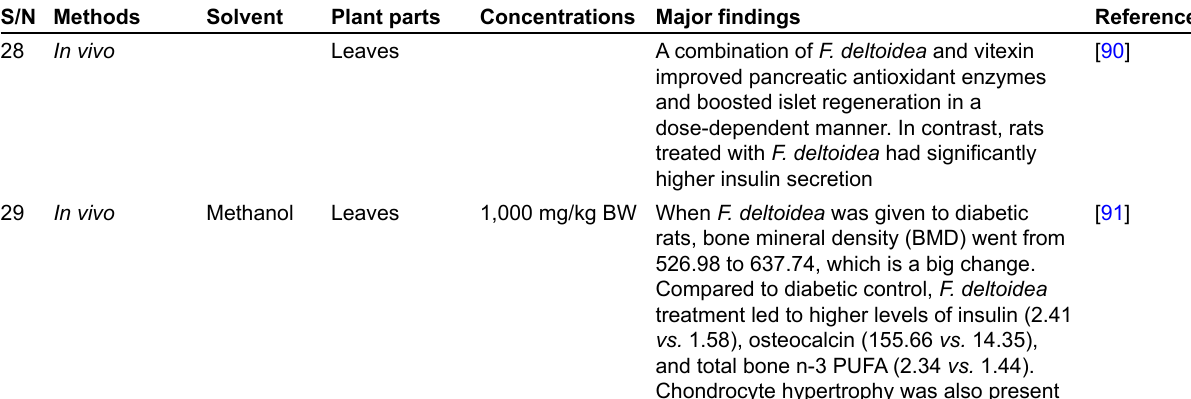
Table 4. FD effects on the endocrine system ( continued )